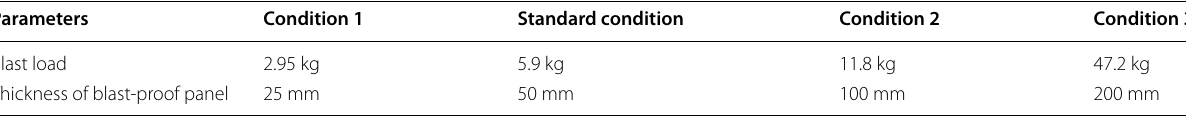
Table 7 Variables considered in parametric study